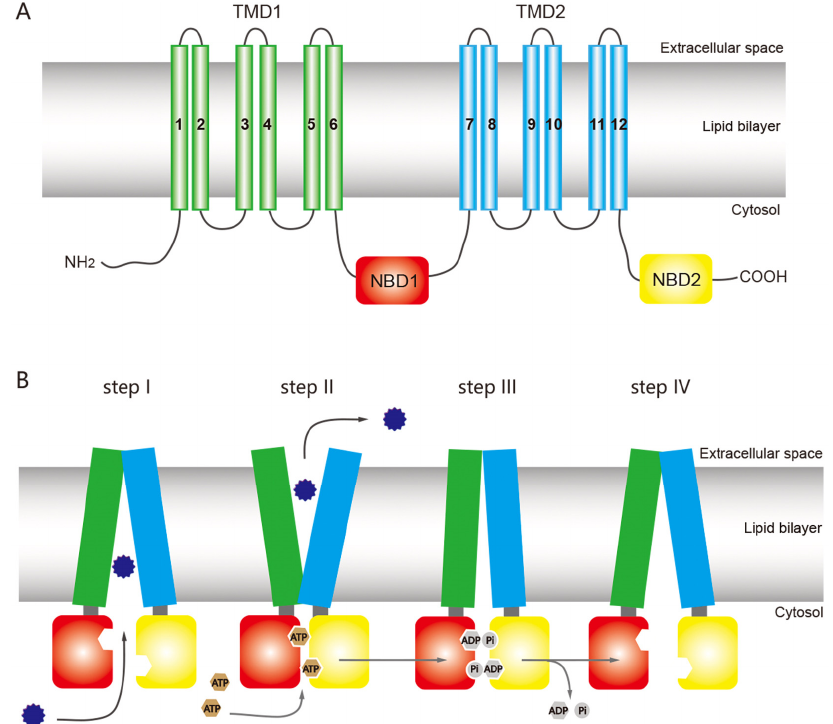
Figure 1. General structure of an ATP-binding cassette (ABC) full transporter (ABC exporter) and the ATP-switch model for the transport mechanism of ABC transporters. ( A ) Typical ABC full transporter with two transmembrane domains (TMDs), TMD1 (green) and TMD2 (sky blue), and two nucleotide-binding domains (NBDs), NBD1 (red) and NBD2 (yellow). Each transmembrane domain